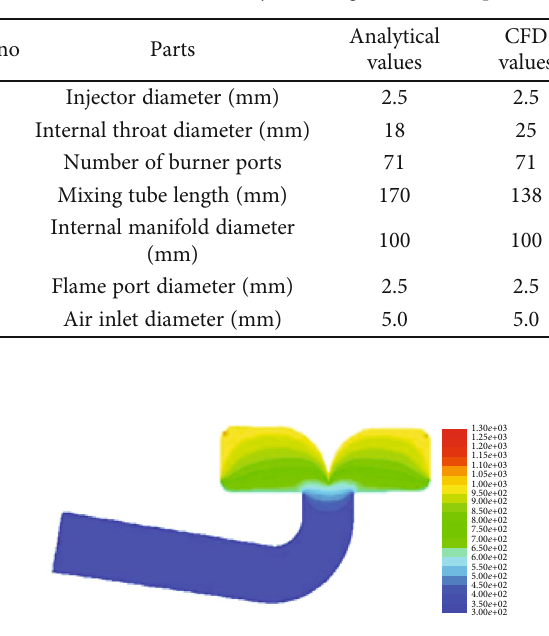
Figure 6: Contours of static temperature along the burner.